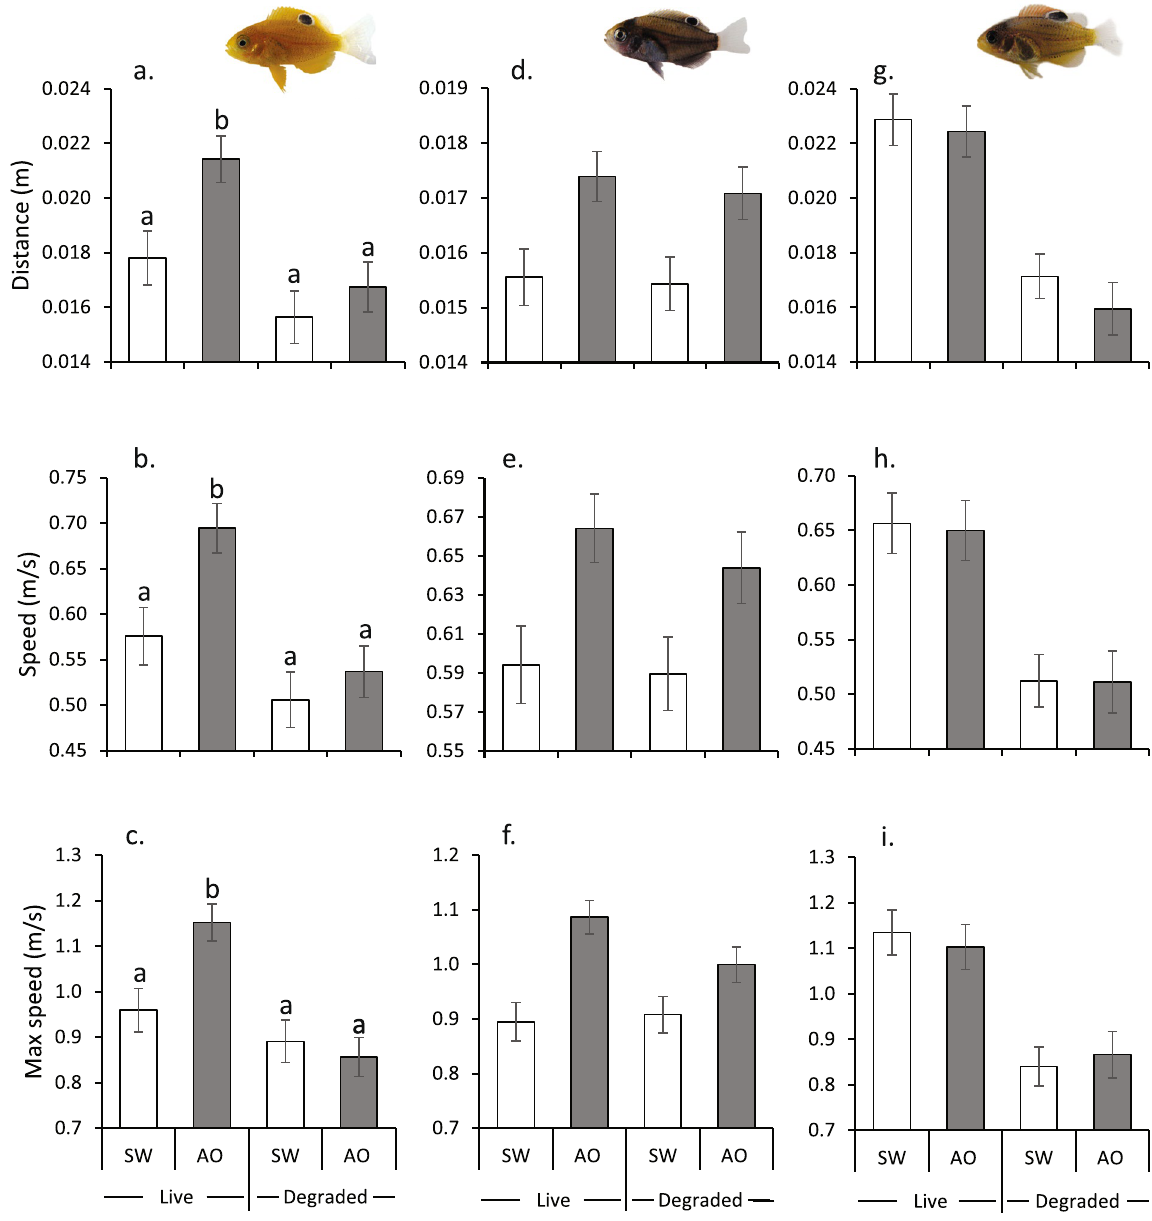
Figure 1. Comparison of the mean ( ± SE) fast-start performance of three damselfish species, the Ambon damsel ( Pomacentrus amboinensis ; a – c ), the whitetail damselfish ( P. chrysurus ; d – f ) and the Ward’s damselfish ( P. wardi ; g – i ) that had been kept in either water that had passed over live coral or degraded-dead coral, and then exposed to either clean seawater (SW) or conspecific alarm odours (AO) prior to a repeatable startle stimulus. Fast-start variables shown are: response distance ( a , d , g ), response speed ( b , e , h ) and maximum speed ( c , f , i ). N = 17–23. Letters above the bars in panels a–c represent Tukey’s means comparison groupings (only tests on significant interactions between factors are shown, p <